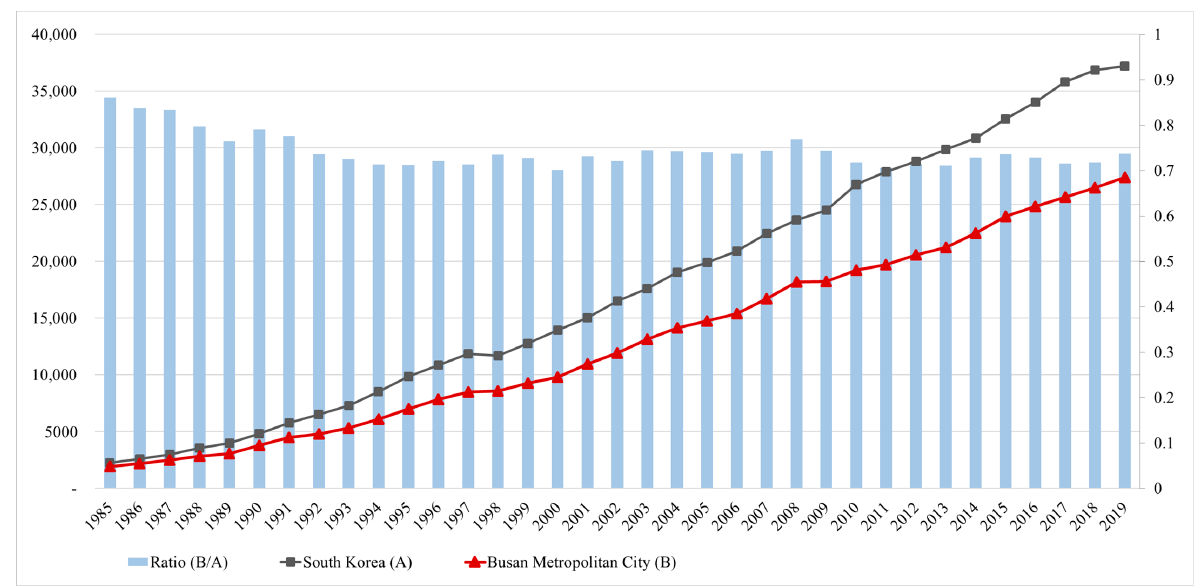
Figure A1. GDP per capita (unit: 1000 won; base year: 2015). Note: Data were drawn from Statistics Korea.